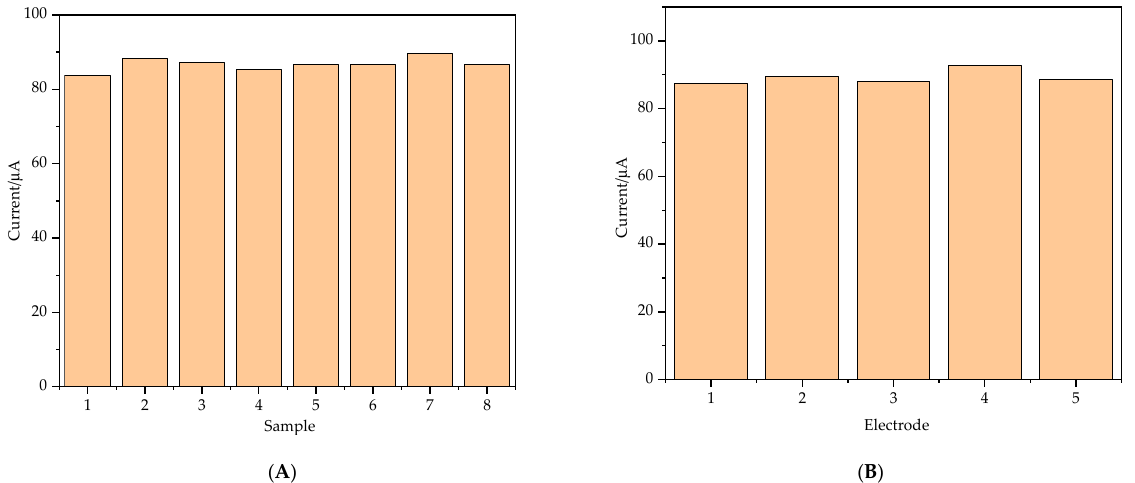
Figure 9. ( A ) AuNPs/MXene/ERGO/GCE detection nitrite in 8 samples with the same concentration. ( B ) The test of five AuNPs/MXene/ERGO/GCE in the same sample.